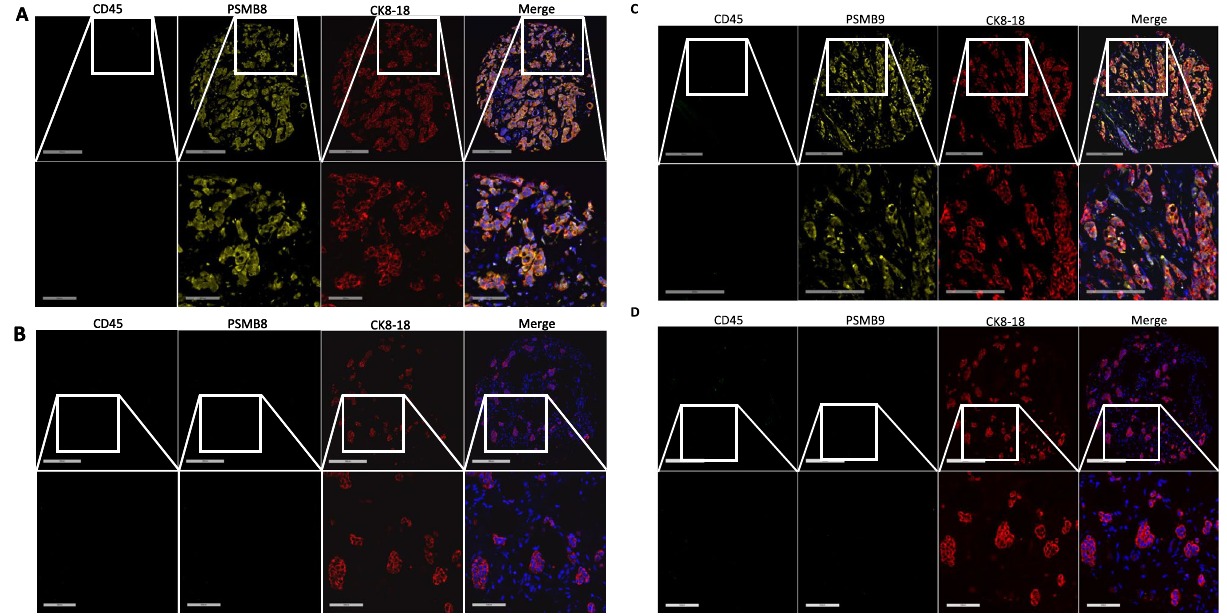
Figure 3. Breast cancer samples have heterogeneous patterns of PSMB8 and PSMB9 expression. IF images of breast cancer samples stained with combinations of ( A ) and ( B ) PSMB8, CD45, CK8-18 and DAPI or ( C ) and ( D ) PSMB9, CD45, CK8-18 and DAPI. Panels ( A) and ( C) are samples representative of high ImP expression and panels ( B ) and ( D ) of low or no ImP expression. Upper panels show the whole sample cores and lower panels are magnifications of the regions delineated by white squares. DAPI (blue), PSMB8 or PSMB9 (yellow), CD45 (green), CK8-18 (red). Whole core scale bar = 300 µm, close-up scale bar = 200 µm ( A ) or 100 µm ( B – D